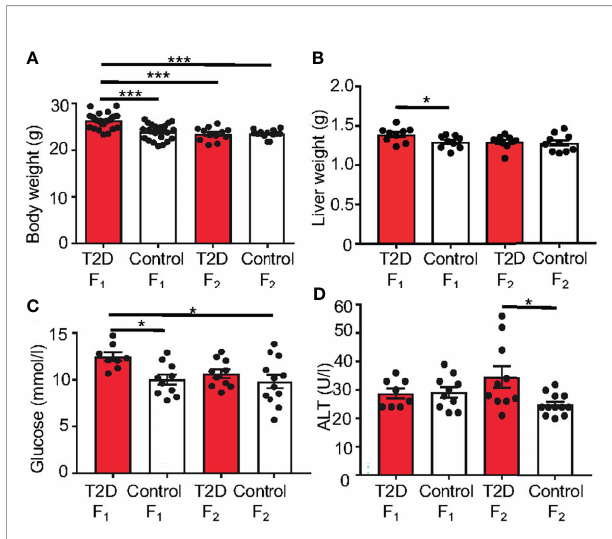
FIGURE 7 | Changes in metabolic characteristics of the offspring generations. (A) Body weight and (B) liver weight at 10 weeks of age. Differences in liver weight between groups were tested by ANCOVA with body weight as covariate (Ancova – STATISTICA 7.0). (C) Fasting plasma glucose and (D) alanine aminotransferase (ALT) levels at 10 weeks of age. Data are presented as the mean ± SEM. Differences were tested by one-way ANOVA, follow by Tukey ’ s post hoc tests for multiple comparisons (GraphPad Prism 7.0). *P < 0.05, ***P <